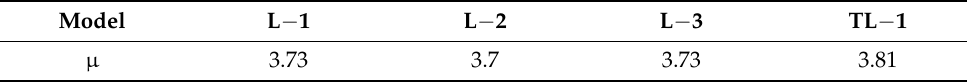
Table 8. Ductility